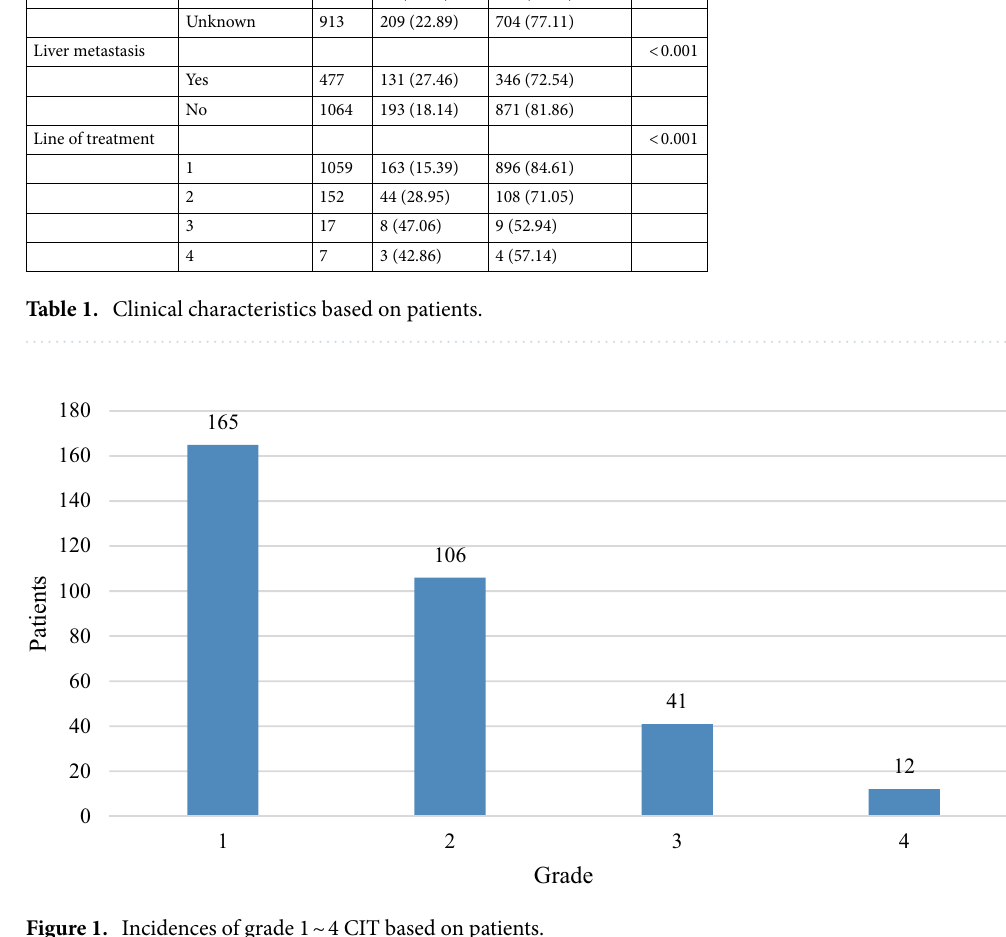
Figure 1. Incidences of grade 1 ~ 4 CIT based on